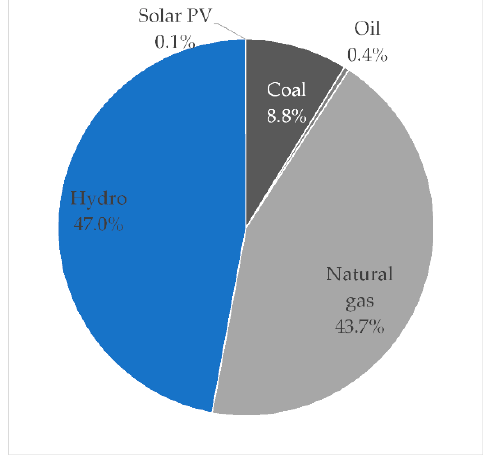
Figure 2. Current share of electricity generation by sources [43].